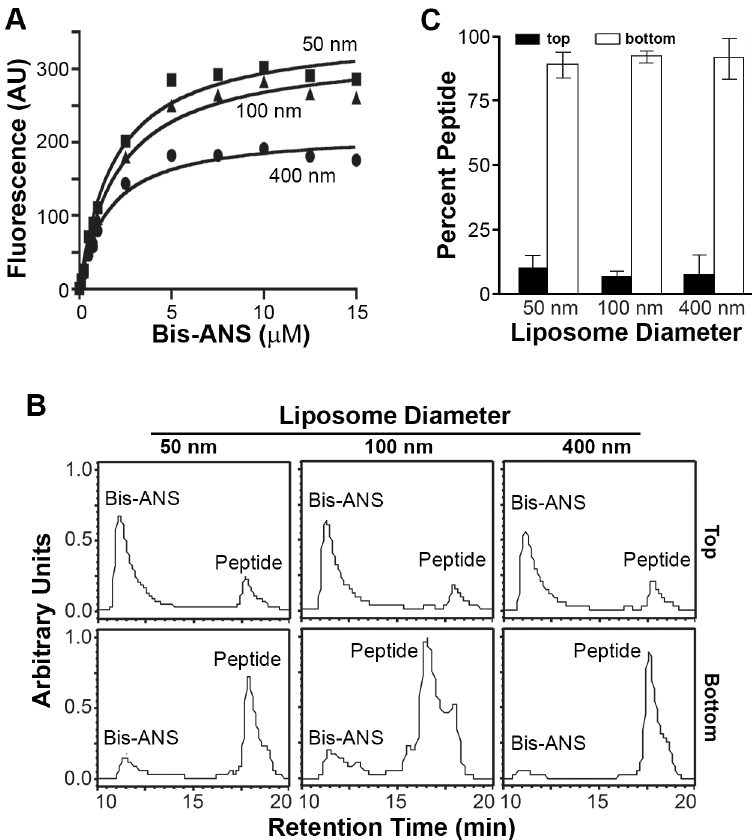
Fig 5. Partitioning of p15HPpep into liposomes is based on curvature-dependent hydrophobic defects. (A) Partitioning curves of bis-ANS in 100 mM suspensions of 50 nm, 100 nm, and 400 nm liposomes. bis-ANS fluorescence was fit to one-site binding hyperbola nonlinear regression using GraphPad Prism. Data points represent the mean of three experiments, with error bars contained within the symbols on the graph. (B) HPLC chromatograms in arbitrary units of absorbance at 215 nm of the top (liposomes) and bottom (free peptide) fractions from sucrose gradients following partitioning of wt p15HPpep into liposomes of the indicated diameter as described in Fig 4A, except liposomes were pre-treated with 10 mM bis-ANS before p15HPpep addition. Note that retention times of the wt p15HPpep differ from Fig 4 due to use of a different HPLC column. (C) As in panel B, quantifying percent p15HPpep associated with top (black bars) and bottom (white bars) sucrose fractions based on integrating the area under the chromatogram peaks. Results are mean SEM from three independent